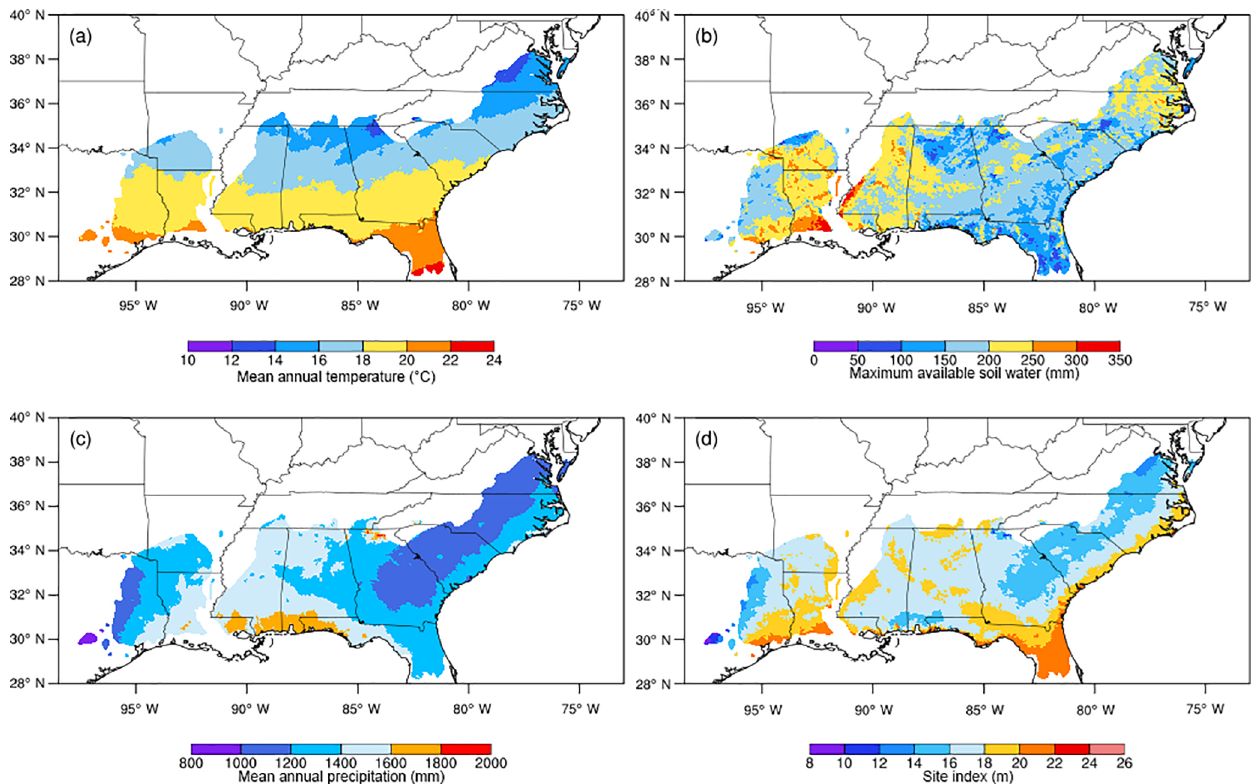
Figure 3. Key climatic and stand characteristic inputs to the regional 3-PG simulations: (a) mean annual temperature (1979–2011) as a summary of the gradient in monthly temperature inputs used in simulations, (b) maximum available soil water for the top 1.5m of soil from SSURGO, (c) mean annual precipitation (1979–2011) as a summary of the gradient in monthly precipitation inputs used in simulations, and (d) site index. The area shown is the natural range of loblolly pine ( Pinus taeda